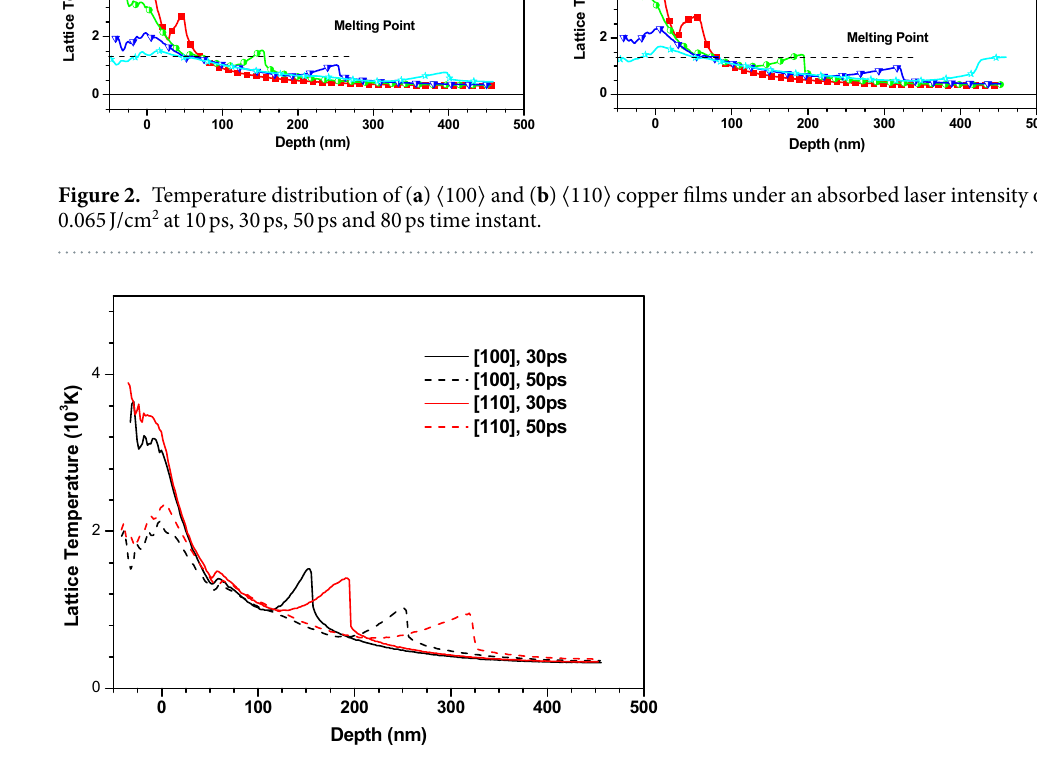
Figure 3. The contrast of temperature distributions of 〈 100 〉 and 〈 110 〉 copper films under an absorbed laser intensity of 0.065 J/cm 2 at 30 ps and 50 ps time